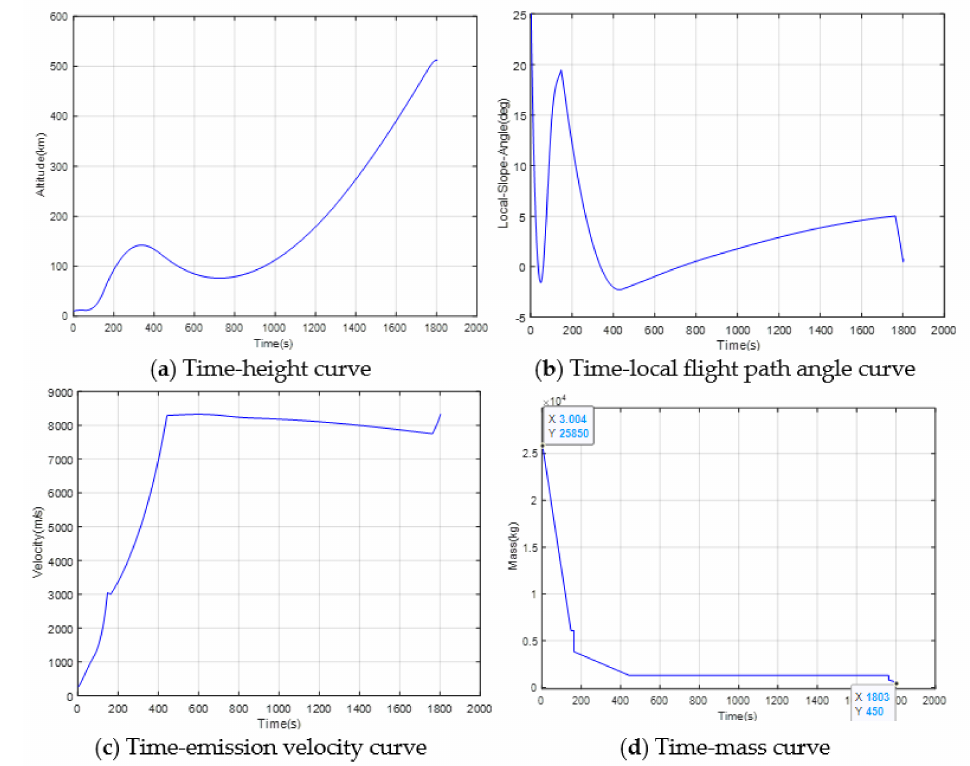
Figure 2. The trajectory of the LauncherOne